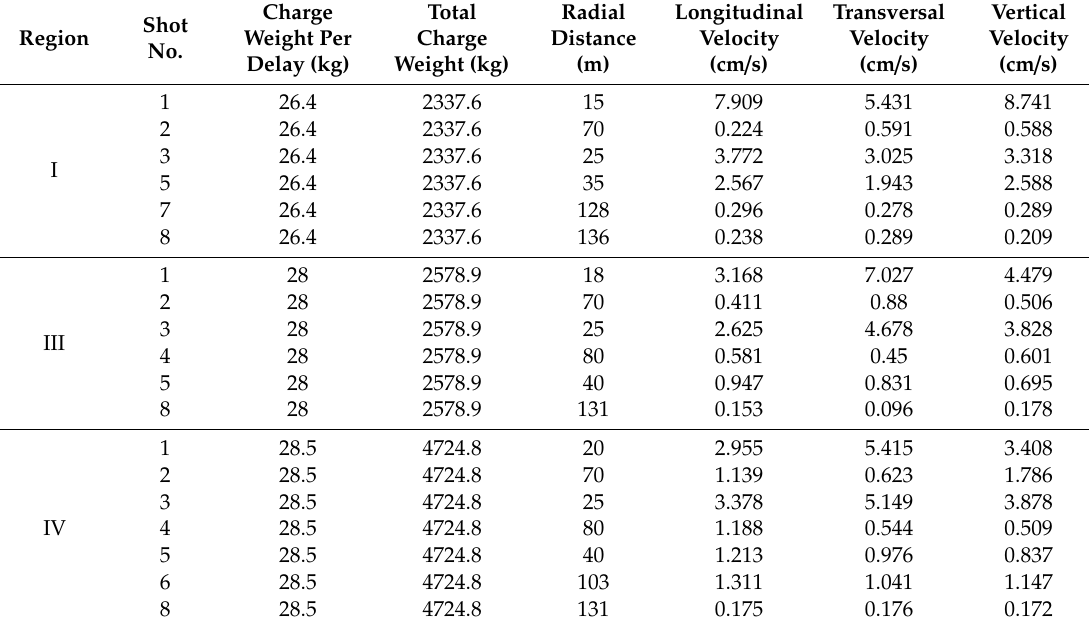
Table 1. Recorded blast vibration